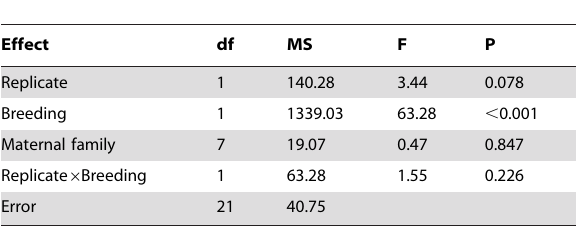
Table 2. Variance analysis for ramet production.